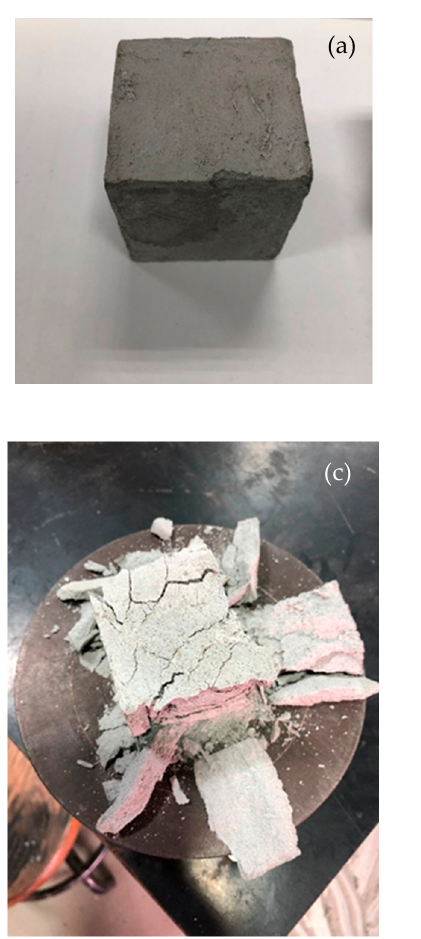
Figure 3. The images of concrete samples under different situations: ( a ) Concrete No. 1 made of cement and sand; ( b ) concrete No. 2 made of cement and heated glass fiber waste; ( c ) compressive test of concrete No. 1; ( d ) compressive test of concrete No. 2.